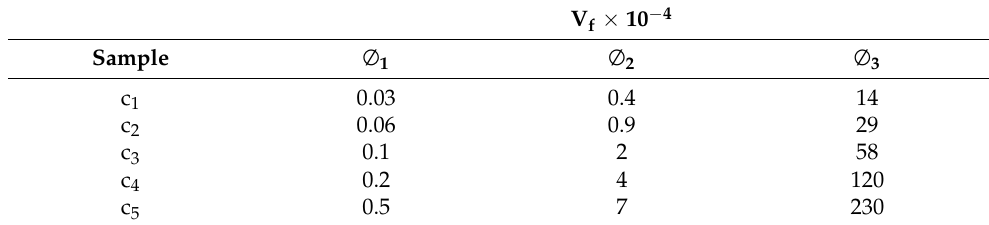
Table 3. Volume fraction for suspensions with particles of ∅ 1 , ∅ 2 and ∅ 3 .